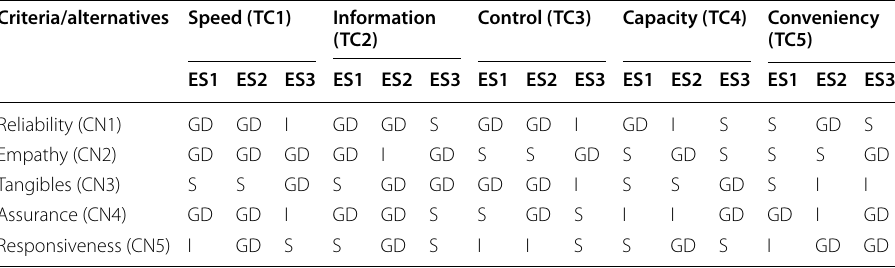
Table 20 LEs for the phase 1 of QFD